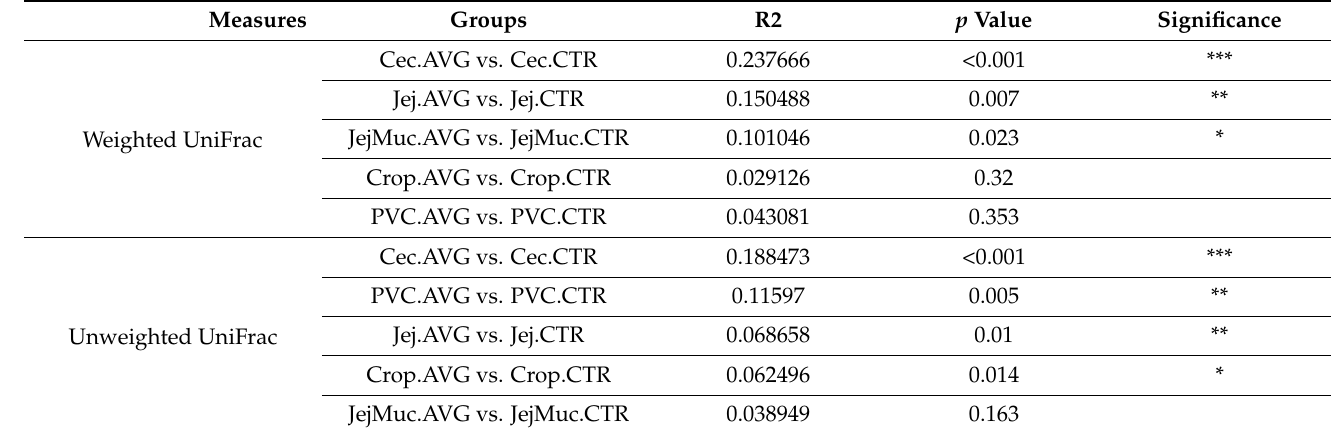
Table 2. PAIRED MANOVA effects of AVG on intestinal microbiota of different gut origins .